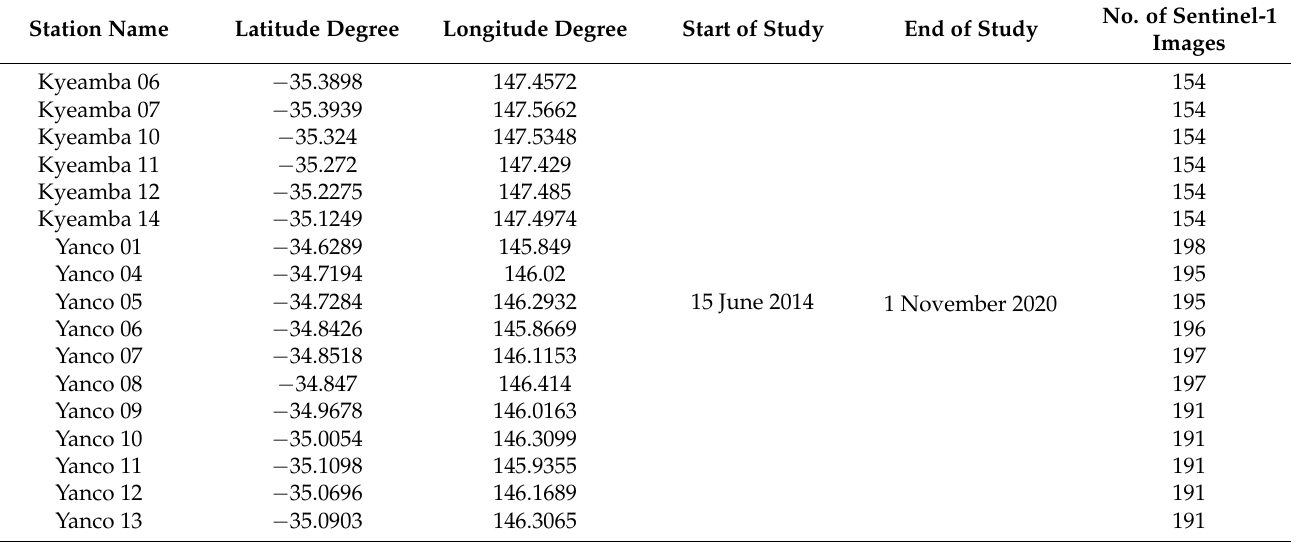
Table 1. Coordinates for each station of the OZNET network together with the number of Sentinel-1 images available for the location of each station.